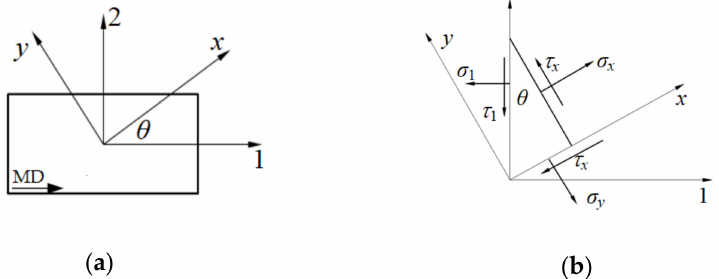
Figure 7. Diagram of separator plane coordinate system: ( a ) Rotating coordinate system in the separator plane; ( b ) Equilibrium coordinate system in oblique